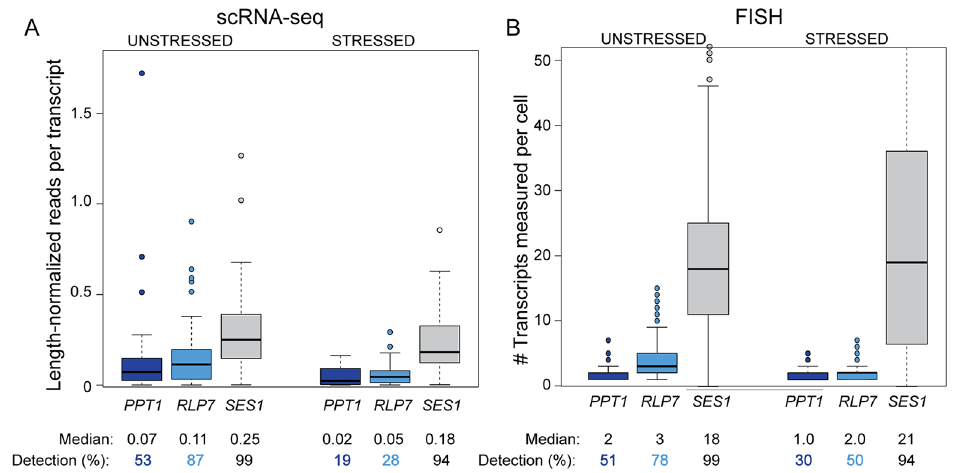
Fig 4. Single-molecule FISH confirms differences in detection rate at severaltranscripts. Distributions of (A) length-normalizedread counts measured by scRNA-seqand (B) mRNA moleculesper cell measured by single-molecule FISH, for PPT1 , RLP7 , and SES1 as a control. Note only part of the SES1 distributionis shown. Mediancounts in cells with a measurement and detectionrate (percentageof cells with